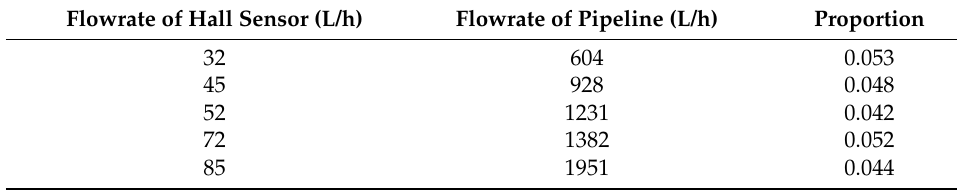
Figure 7. Schematic of broken pipeline with hall sensors. The fact that point A and B contact air allows us to view the pressure of point A and B as zero, as shown in Equation (8).